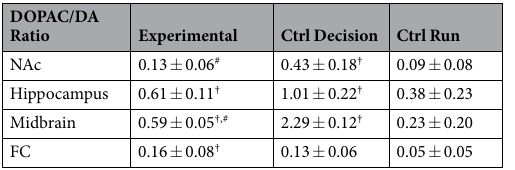
Table 1. DOPAC/DA ratio. Bonferroni’s post-hoc analysis significance: # p < 0.01 vs. CtrlDec; † p < 0.01 vs. CtrlRun.